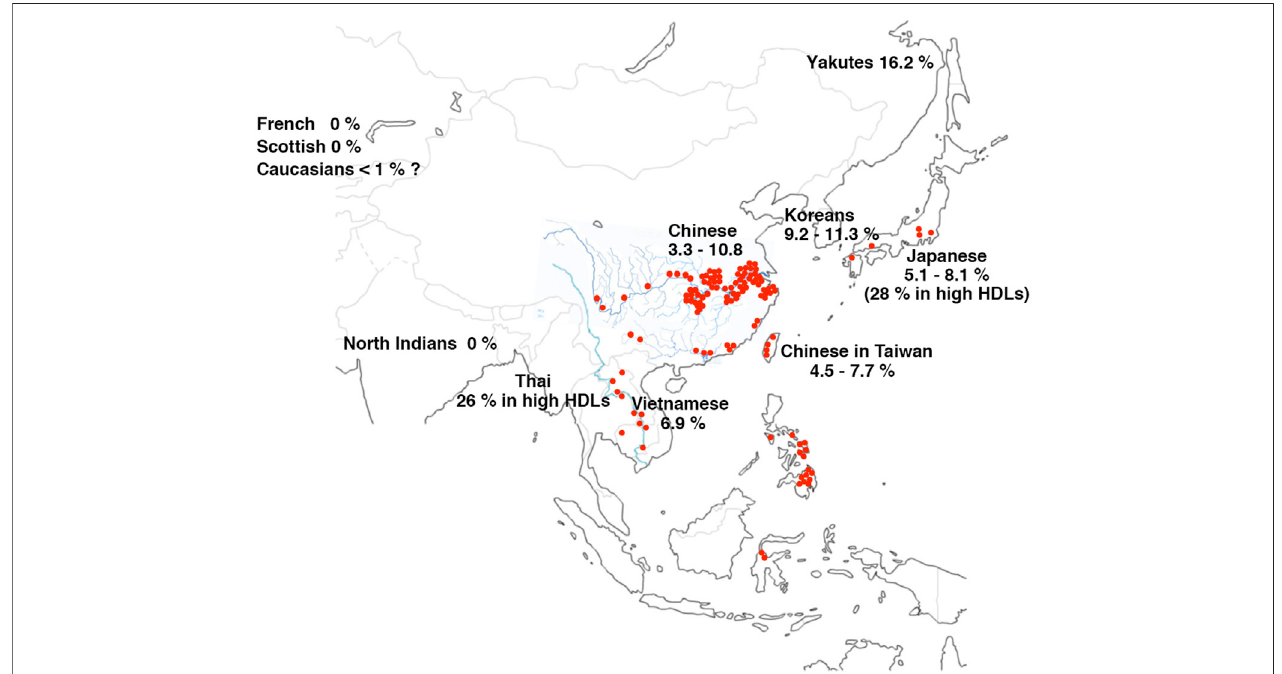
FIGURE 8 | Endemics map of S. japonicum and CETP de fi ciency (D442G). Red spots show the regions where the cases of infection by S. japonicum were found currentlyandhistoricallysincetheearly20thcenturywhentheparasitewasidenti fi ed.TheregionsspreadoverJapan,ChinaincludingTaiwan,Mekongvalleys,Thailand, Philippines, andIndonesia. Theendemicwaseliminated inmany oftheseregionsbythe21stcentury.DataoftheprevalenceofG442Gavailableinliterature tilltodayare listed as percentage in each ethnic general population as listed in Table 2 .